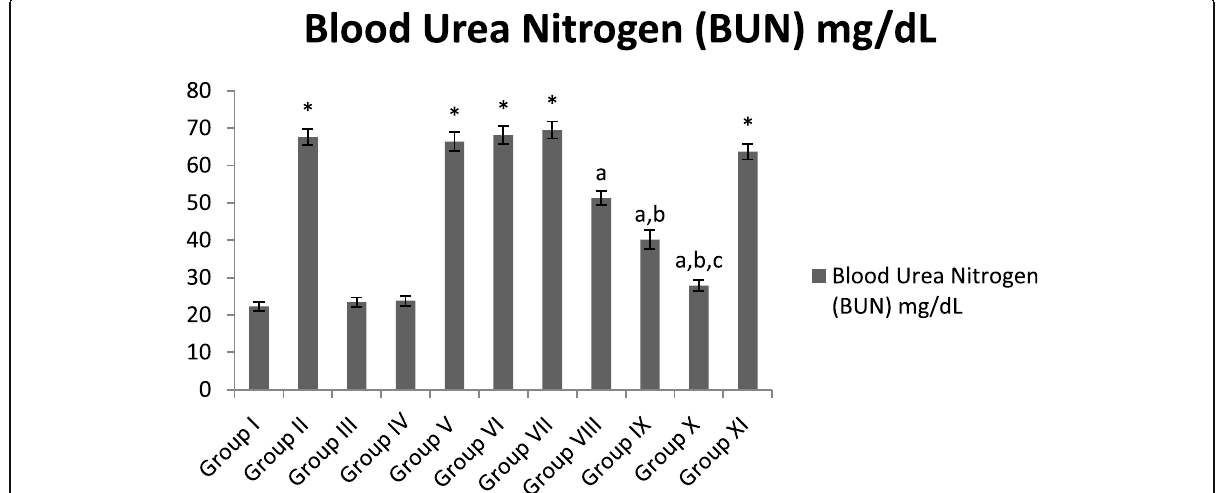
Fig. 2 Graph representing blood urea nitrogen levels (mg/dL). All values were represented as mean ± SEM. * = p < 0.001 versus group I (normal control); a = p < 0.001 versus group II (uninephrectomised diabetic control); b = p < 0.005 versus group V (uninephrectomised diabetic rats with oleamide (1 mg/kg) treatment; c = p < 0.005 versus group VI (uninephrectomised diabetic rats with oleamide (2.5mg/kg) treatment); d = p < 0.001 versus group VI (uninephrectomised diabetic rats with oleomide (5 mg/kg)